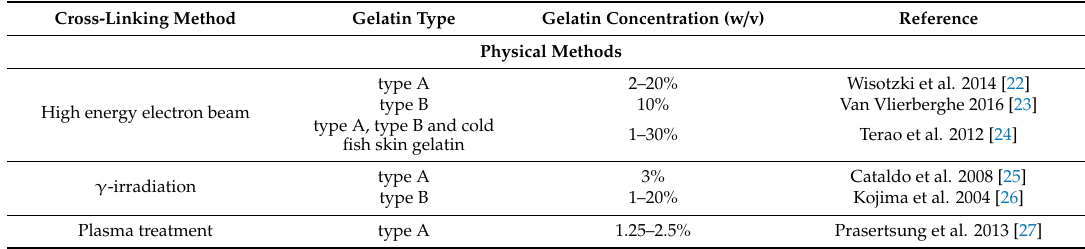
Table 1. Examples of cross-linking methods used for the production of gelatin hydrogels. The cross-linking methods are divided in three categories, physical, chemical, and enzymatic. For each example, the cross-linking methods, gelatin type, and gelatin concentration used are reported.